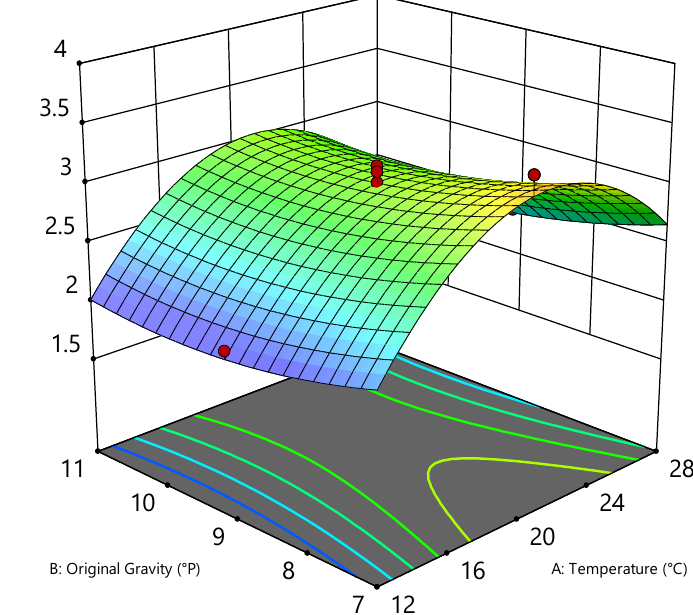
Figure 1. Three-dimensional (3D) diagram of the quadratic correlation between original gravity (°P), temperature (°C), and the sum of esters concentration (mg/L) of the beers at a pitching rate of 15 × 10 6 cells/mL.